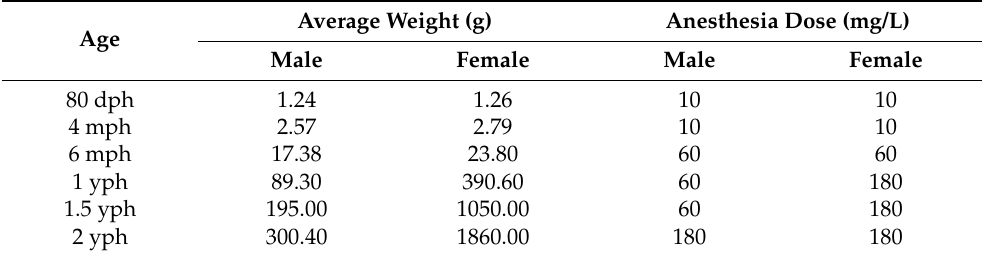
Table 1. Anesthetic doses for different fish ages and weights (dph: day post-hatching; mph: month post-hatching; yph: year post-hatching).